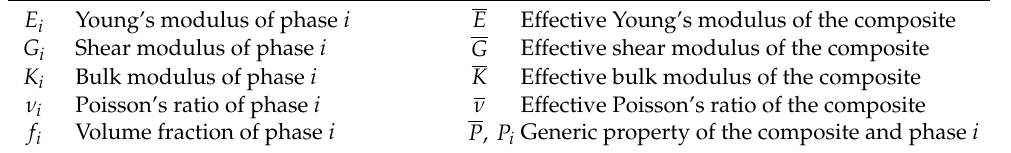
Table 2. Symbols of composite and phase